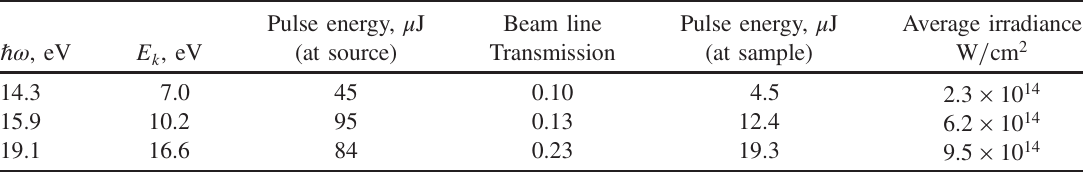
TABLE I. Experimental parameters. E is the kinetic energy of the Ne 2 p photoelectrons. The pulse energies at the k sample are calculated by multiplying the values at the source by the transmission of the beam line [37], which takes account of reflection and geometric losses. Pulse energies and irradiance are those of the